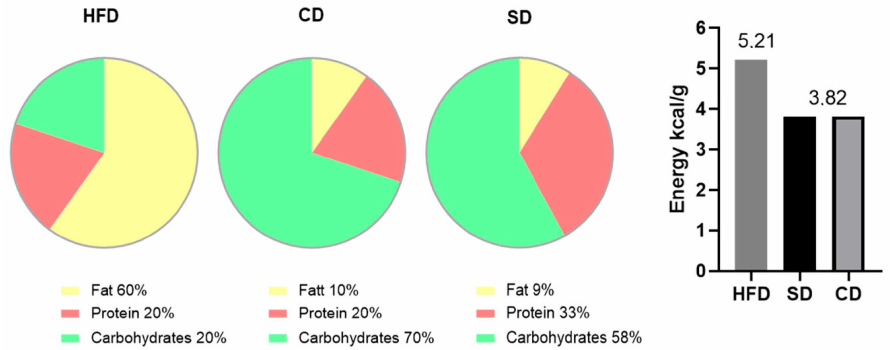
Figure 1. Composition of high fat diet (HFD), control diet (CD) and standard diet (SD) in % of total calories and energy density in kcal /